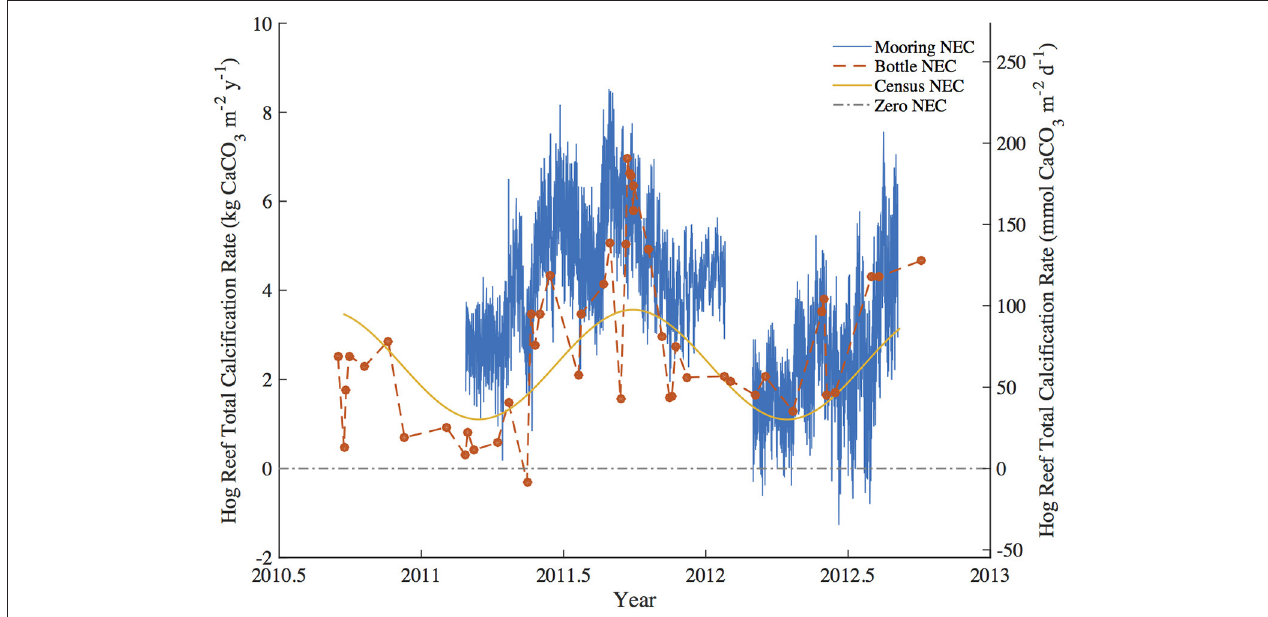
FIGURE 3 | Summary figure of Hog Reef Net Ecosystem Calcification (NEC) using the mooring NEC, bottle NEC, and census NEC approaches for the study period. The dashed zero-NEC line indicates the tipping point between net calcification (above the line) and net CaCO 3 dissolution (below the line).